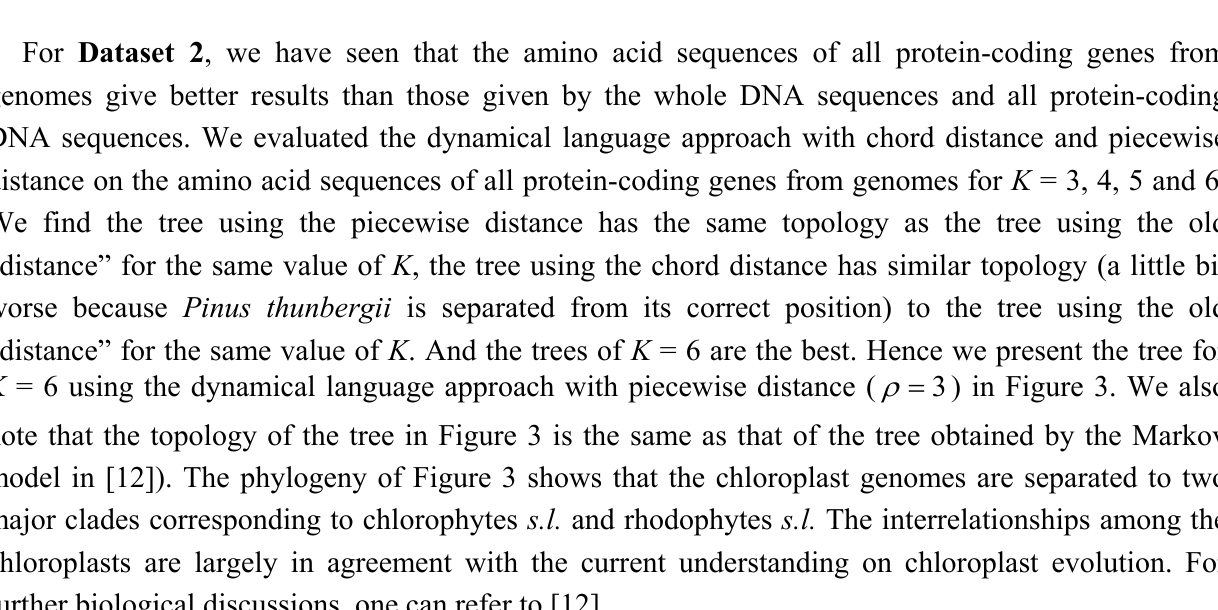
Figure 3. Phylogeny of chloroplast genomes using the dynamical language approach with piecewise distance in the case K = 6 based on all protein